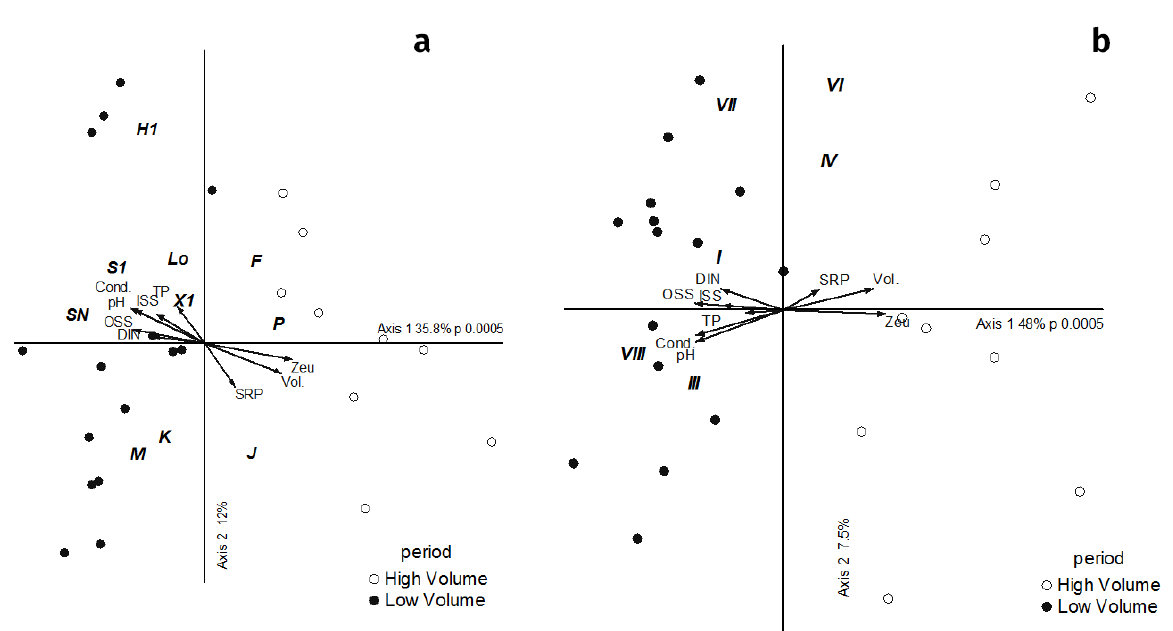
Figure 6. Redundancy analysis diagrams using Reynolds’s Functional Groups (RFG) approach ( a ) and Morphology- Based Funcional Groups (MBFG) approach ( b ) with limnological variables (arrows) and monthly samplings (dots). Cond. = Conductivity; DIN = Dissolved Inorganic Nitrogen; ISS = Inorganic Suspended Solids; OSS = Organic Suspended Solids; SRP = Soluble Reactive Phosphorus; TP = Total Phosphorus; Vol . = Water volume; z